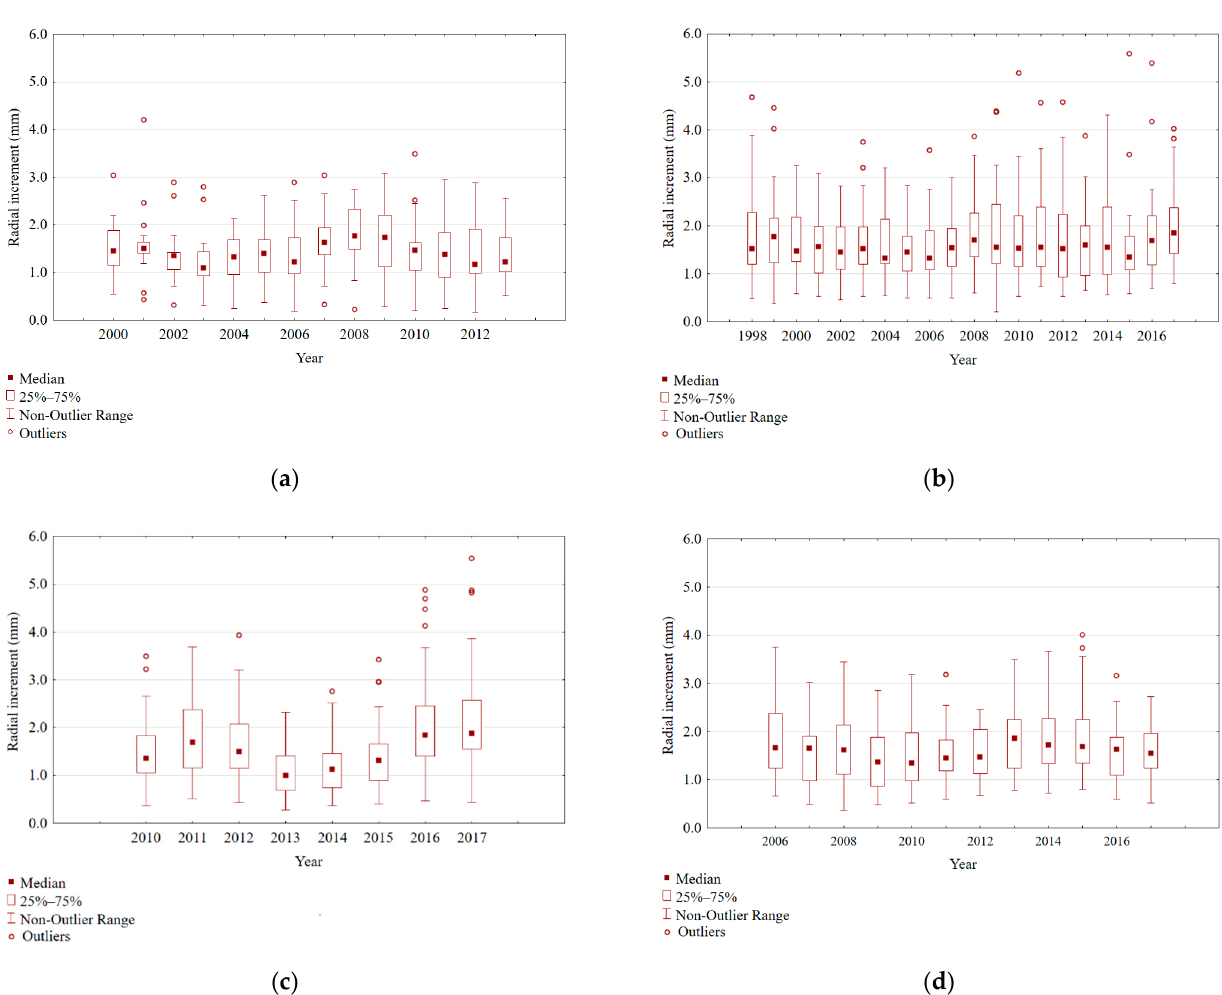
Figure 3. Minimum and maximum values of tree-ring width of Scots pine in the Maskuli ń skie ( a ), Soko ł ów ( b ), Celestynów ( c ) and Biłgoraj ( d ) forest districts. Table 5. Regression (r 2 ) and statistical significance ( p ) of Scots pine radial increments before (Zd_Before) and after (Zd_After) construction of hydrotechnical facilities, depending on the distance. Forest